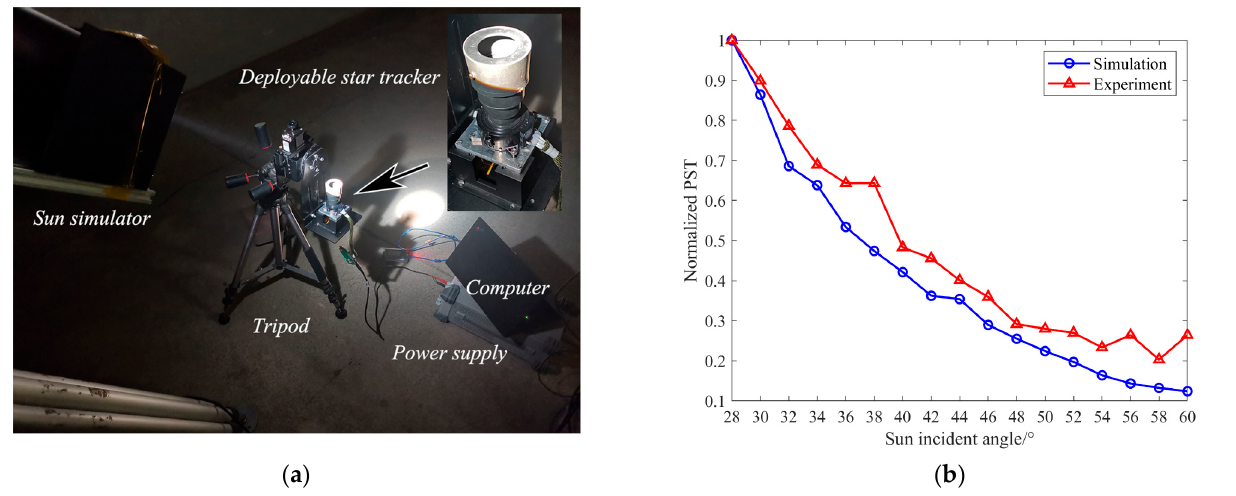
Figure 16. ( a ) Practical stray light experiment for DST with sun simulator. ( b ) Normalized PST comparison between simulation and practical experiment (The normalized PST value is relative to the value of the sun angle of 28°).